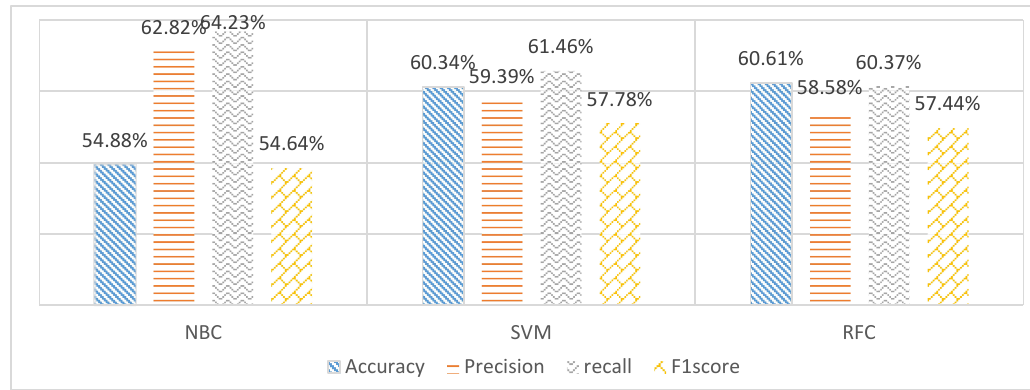
Fig. 4. Graph of comparison of quality measures in the detection of